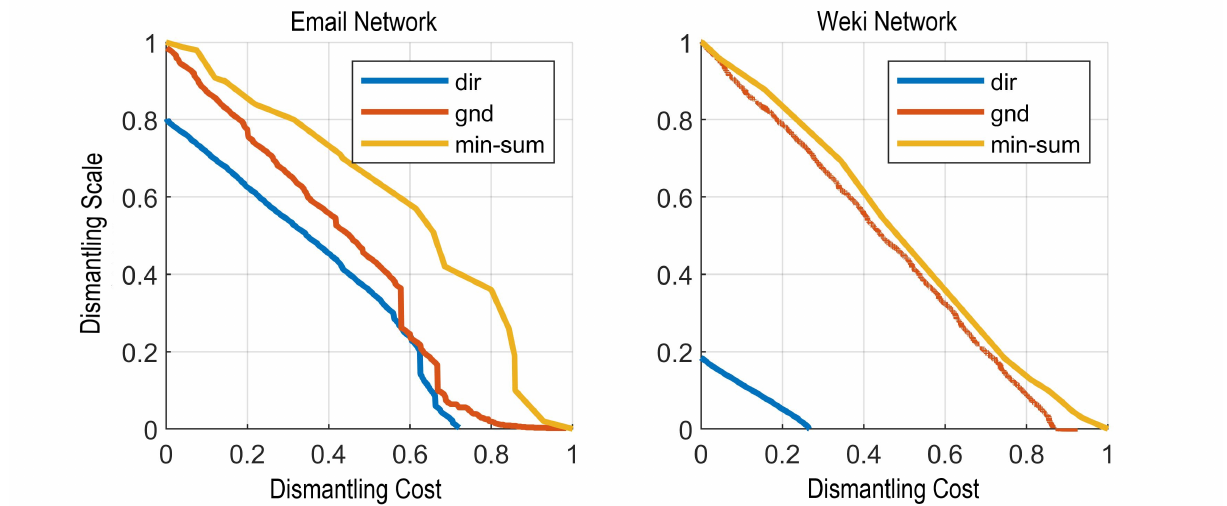
Figure 3. Curve graph of directed real network disassembly cost and disassembly